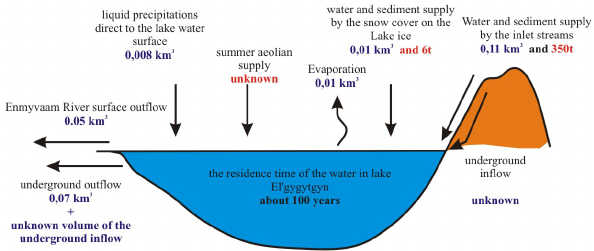
Fig. 4. Sketch of Lake El’gygytgyn water balance and sediment